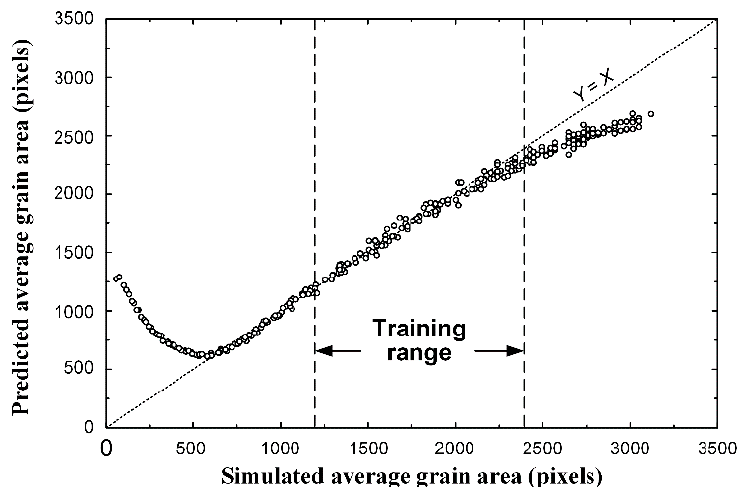
Figure 8. Comparison between the measured and predicted average grain area for another test dataset of 300 simulated images. In this case, the grain size ranges were between 50 and 3200 pixels, while the ranges for the training dataset was between 1200 and 2400, approximately.